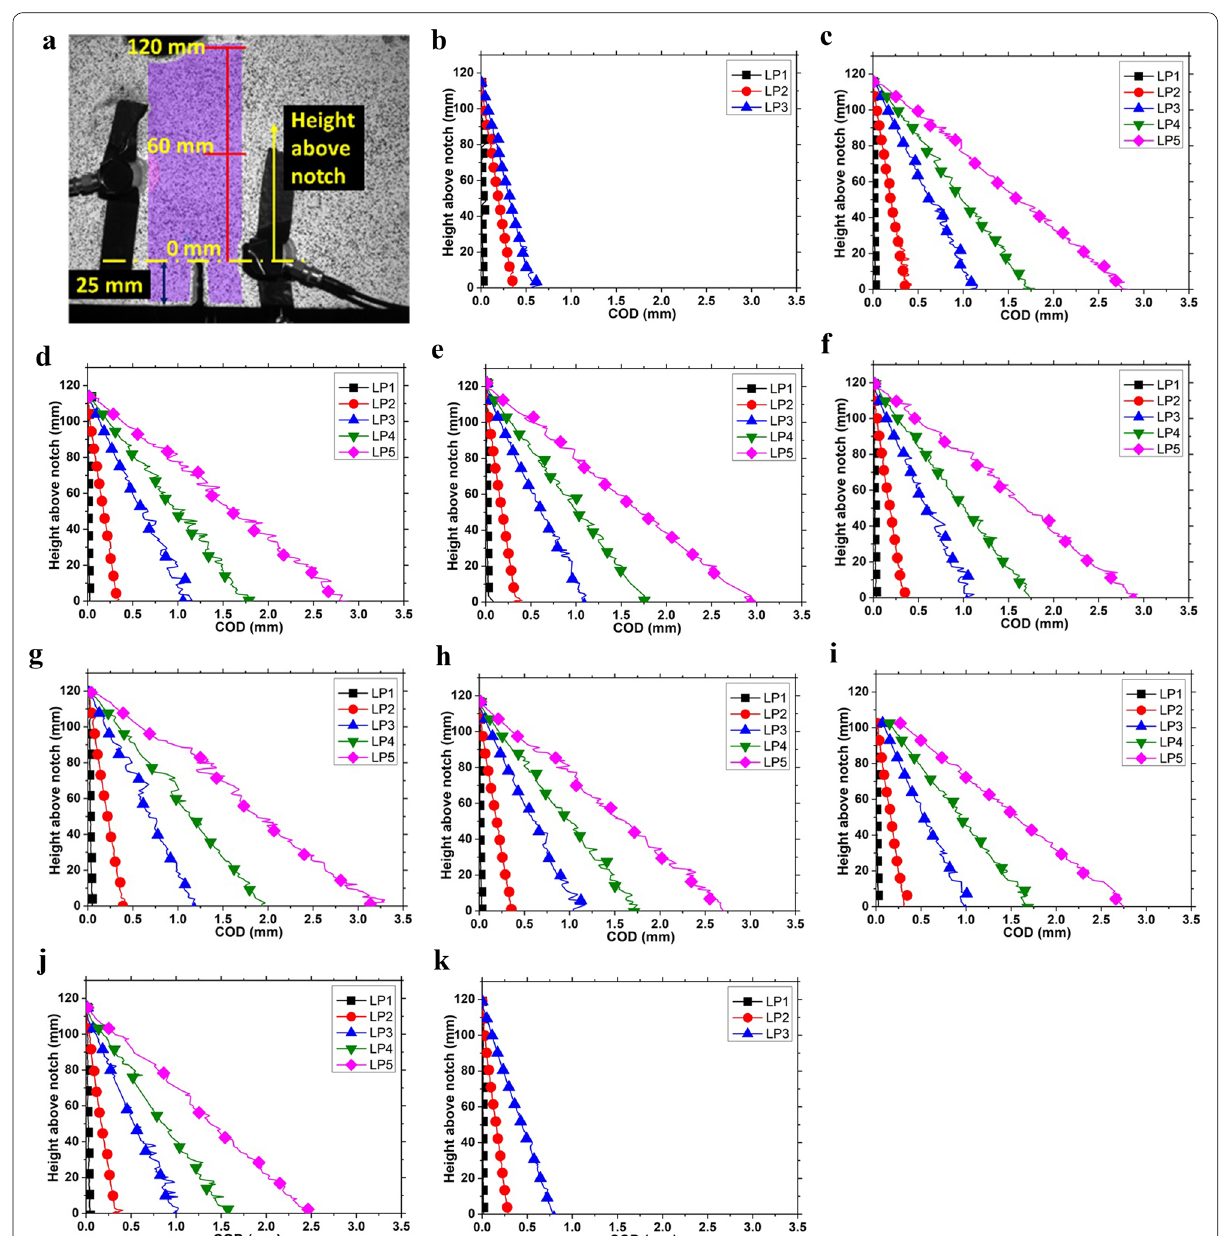
Fig. 16 Distribution of COD along the depth for different fibre types and dosages at all loading points: a COD measurement from DIC; b control beam; c PO50; d PO75; e PO100; f HB50; g HB75; h HB100; i SF50; j SF75; k SF100